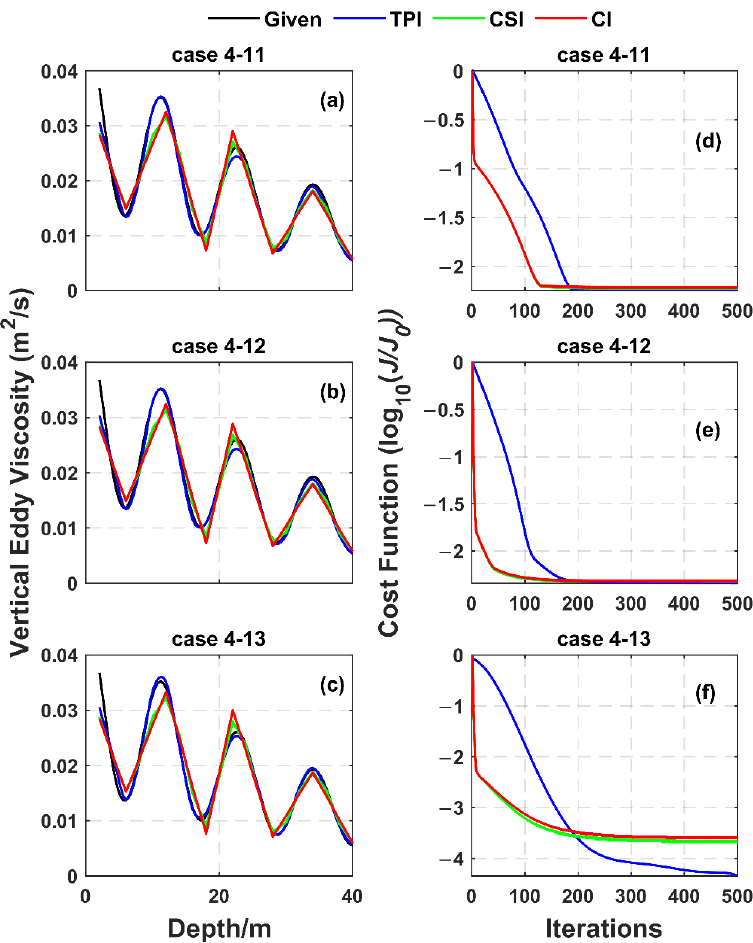
Figure 9. On the left are the prescribed and inverted distributions of the VEVCs after using different distributions of wind stress drag coefficients. Panels ( a – c ) correspond to Cases 4-11, 4-12, and 4-13, respectively. On the right are the cost functions using the three schemes in Group 5. Panels ( d – f ) correspond to Cases 4-11, 4-12, and 4-13, respectively.